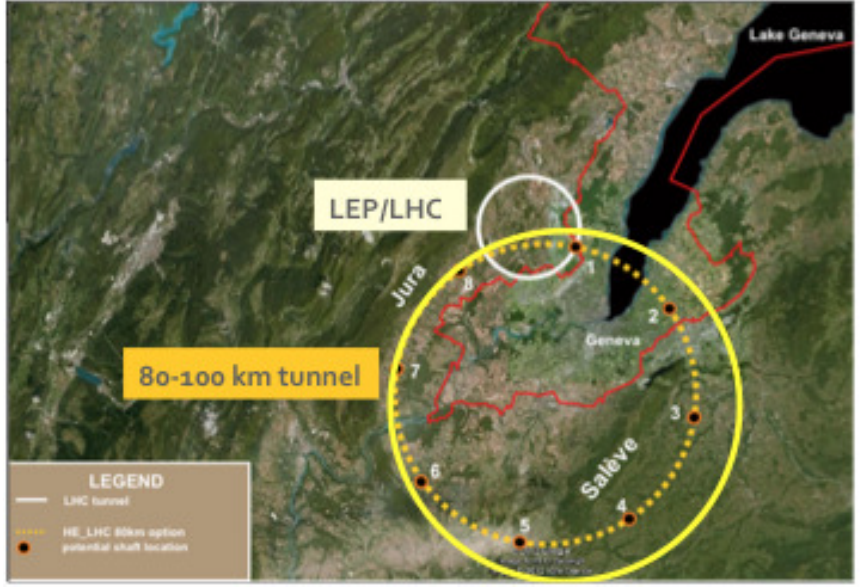
Figure 1. The 80 km tunnel (dashed circle) and the 100 km version (full line) that would host the TLEP and VHE-LHC in the Geneva